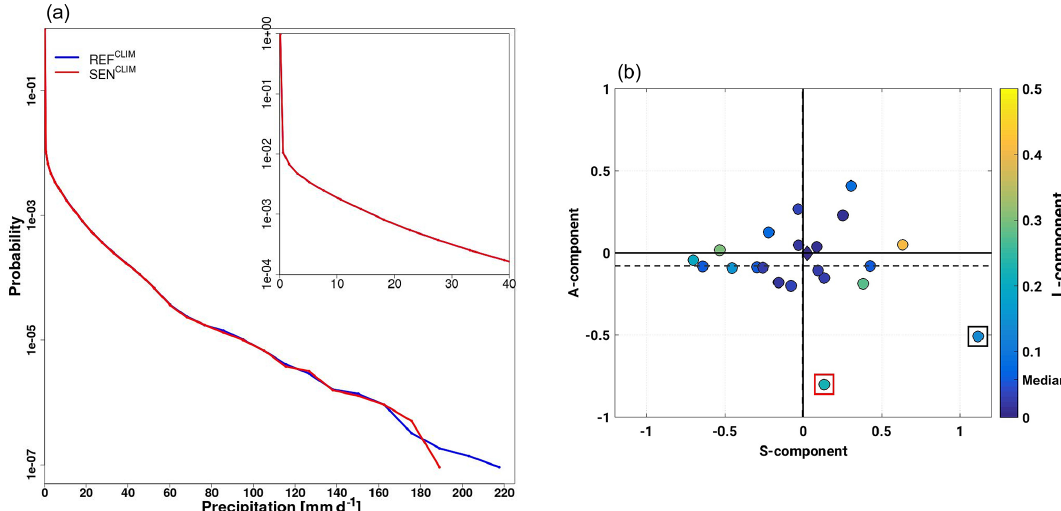
Figure 6. (a) Probability density function of daily precipitation intensities. All grid points in the investigation domain (Fig. 1) and the period 2004 to 2013 are considered. (b) SAL diagram between REF CLIM and SEN CLIM simulations. Every circle corresponds to a simulated heavy precipitation event (listed in Table 1). The diamond (close to zero–zero) illustrates the mean of all events. The A component is amplitude, the S component is structure, and the L component is location. The inner colour indicates the L component. Boxes point out the two events examined in this study, CASE1 and CASE2 (see Sect.